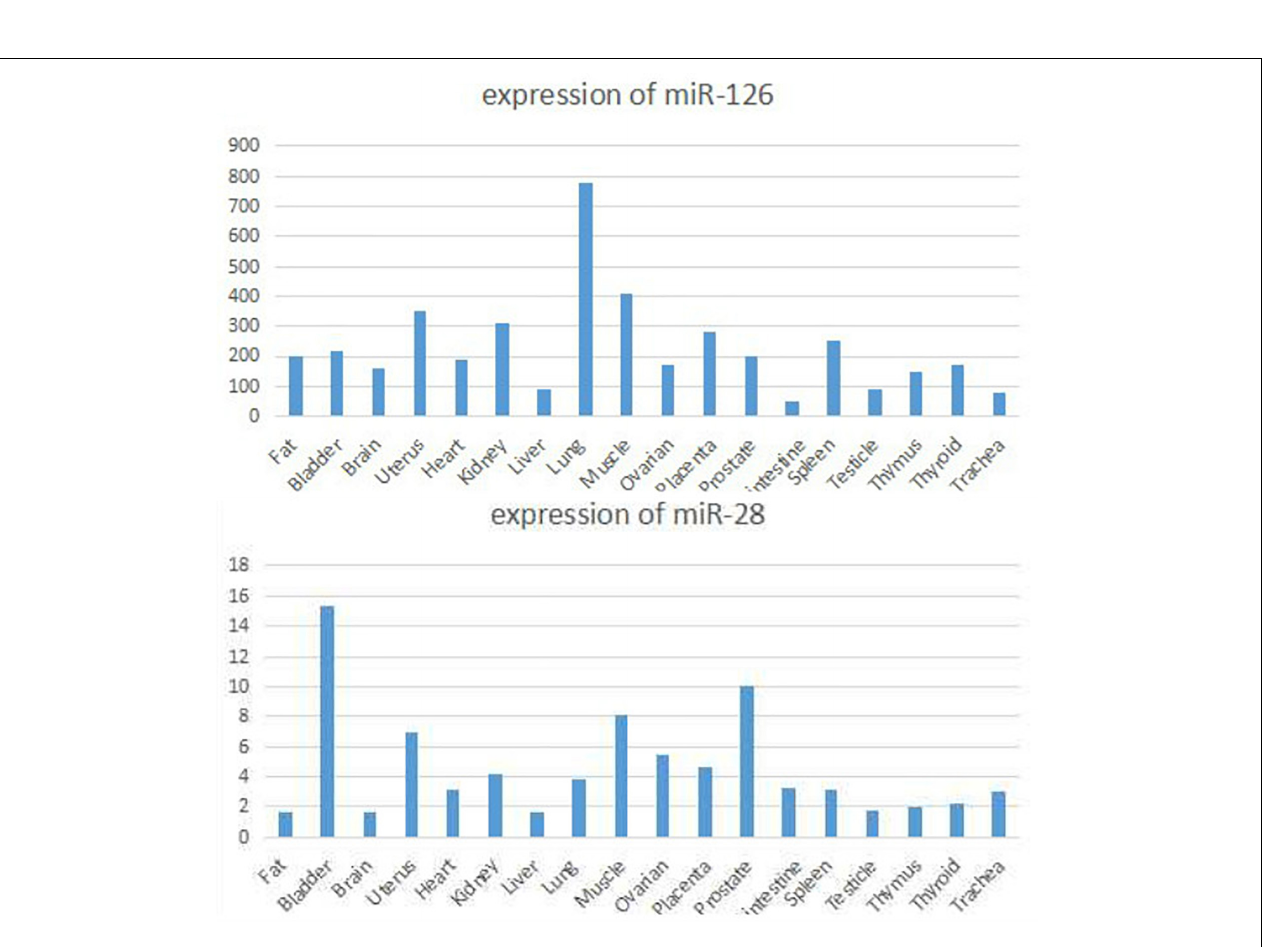
FIGURE 8 | (A) miRNA-126 with associated “sponge” genes and circRNA. (B) miRNA-28-3p with associated “sponge” genes and circRNA.